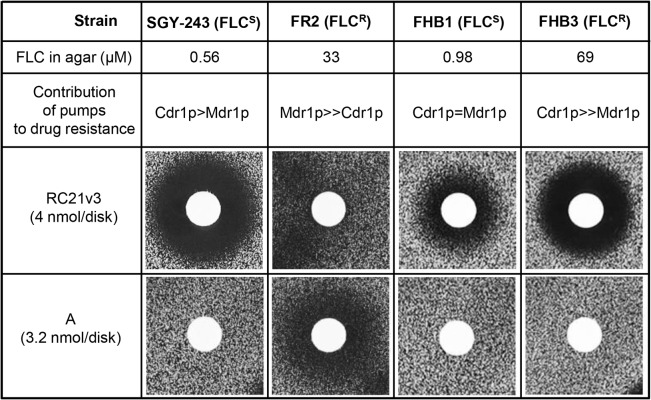
Chemosensitization of C. albicans to FLC.The strains used and conditions for the agarose diffusion assays are described in Materials and methods. FLCS—susceptible to FLC; FLCR—resistant to FLC.